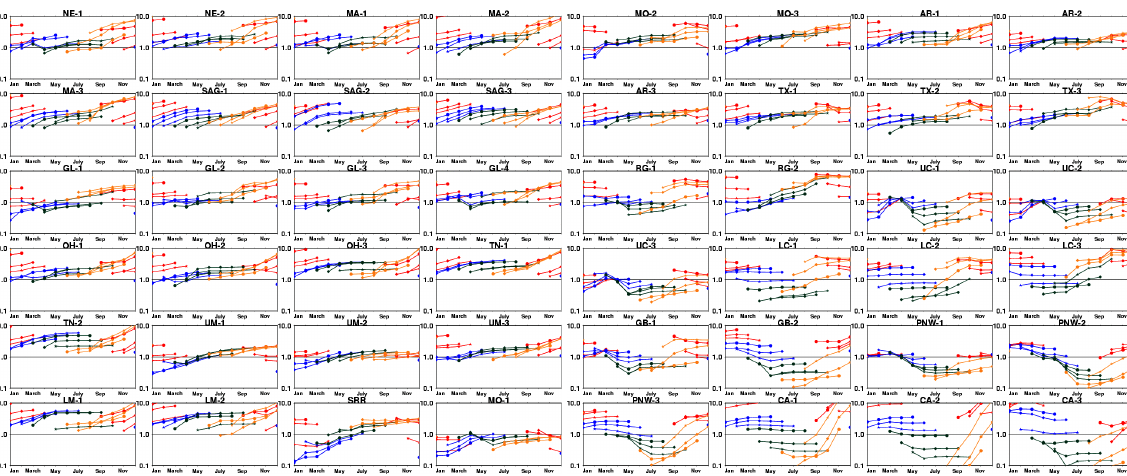
Fig. 3. Variation of RMSE ratio (RMSE ESP /RMSE revESP ) with lead time over 48 hydrologic sub-regions, for the CR forecasts at lead 1–6months, initialized on the beginning of the each month. (DJF: blue, MAM: green, JJA: light brown and SON: red).